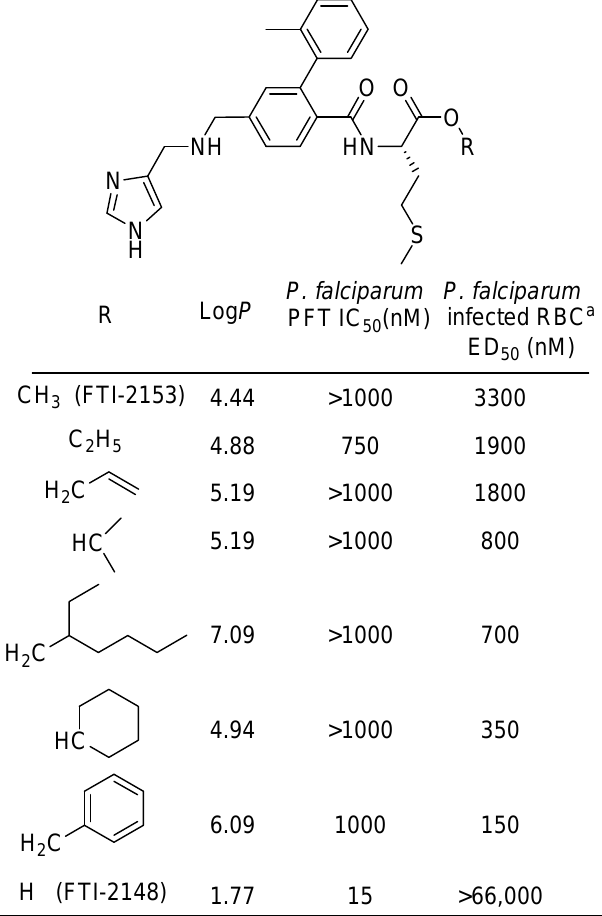
Table 1. Inhibition activity of FTI-2148 prodrugs against P. falciparum PFT and P. falciparum infected red blood